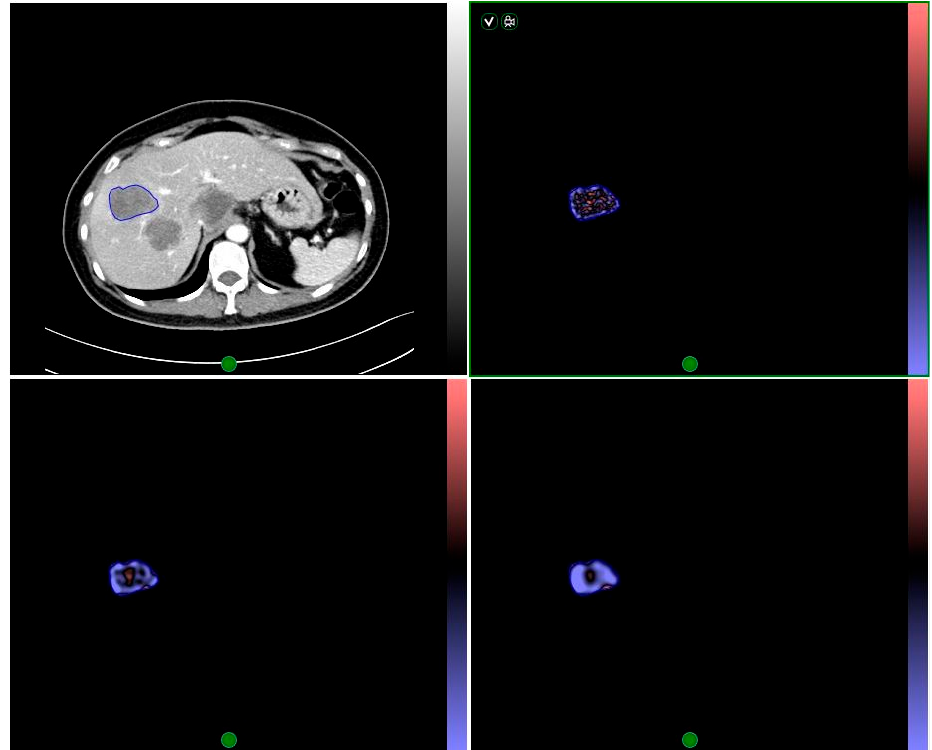
Figure 1. Illustration of lesion delineation, and image filtration at fine, medium, and coarse texture scales.